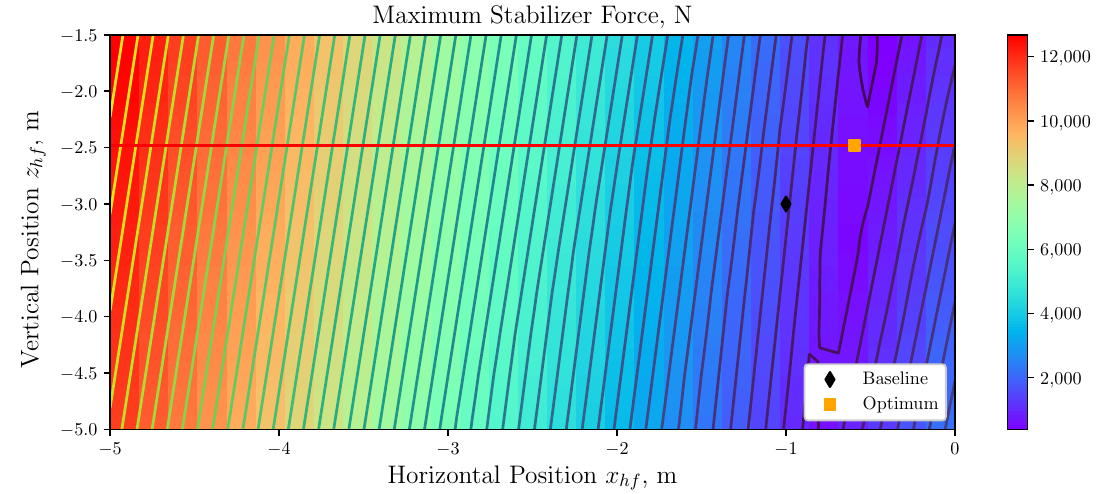
Figure 15. Hydrofoil position design space for the stabilizer force minimization. The red line indicates the upper bound of the hydrofoil’s vertical position.